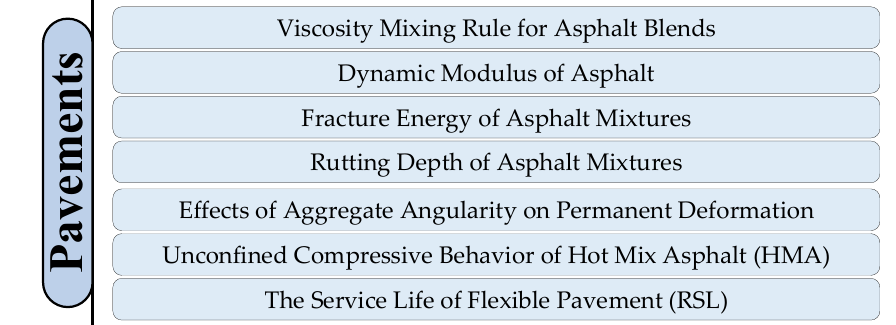
Figure 6. The studied subsections of asphalt (pavement).